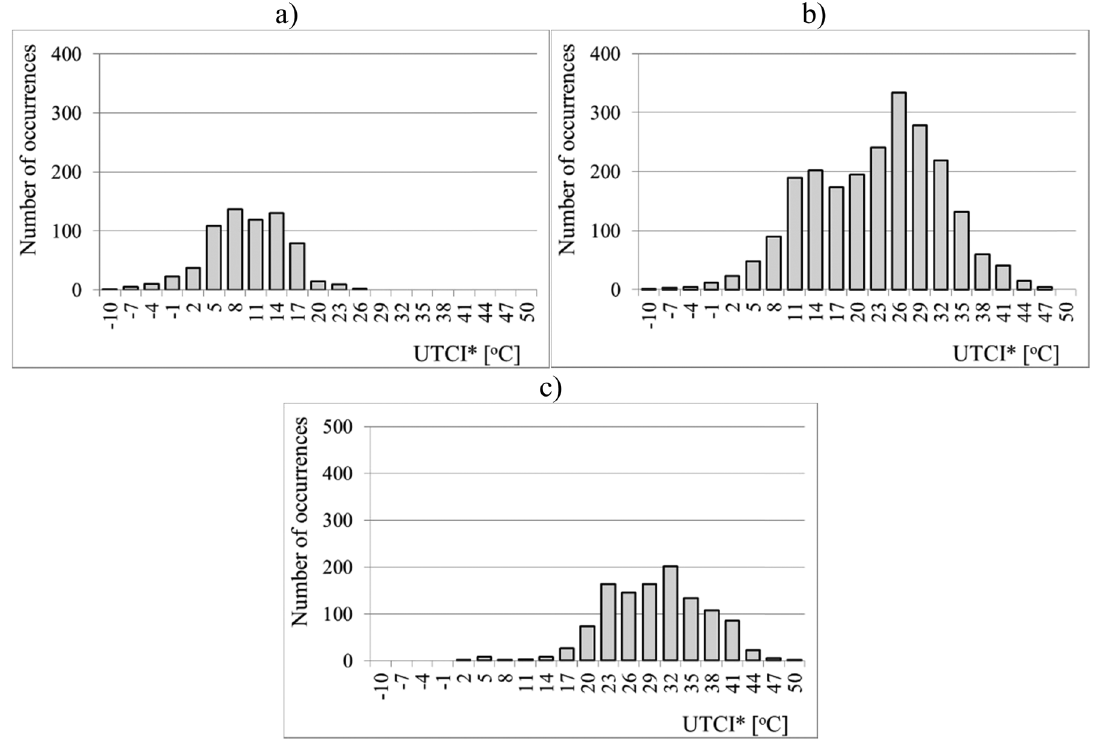
Figure 3: Histogram of UTCI ∗ on 40 sca ff olds measured for: ( a ) fi rst quarter, ( b ) second quarter, and ( c ) third quarter of the